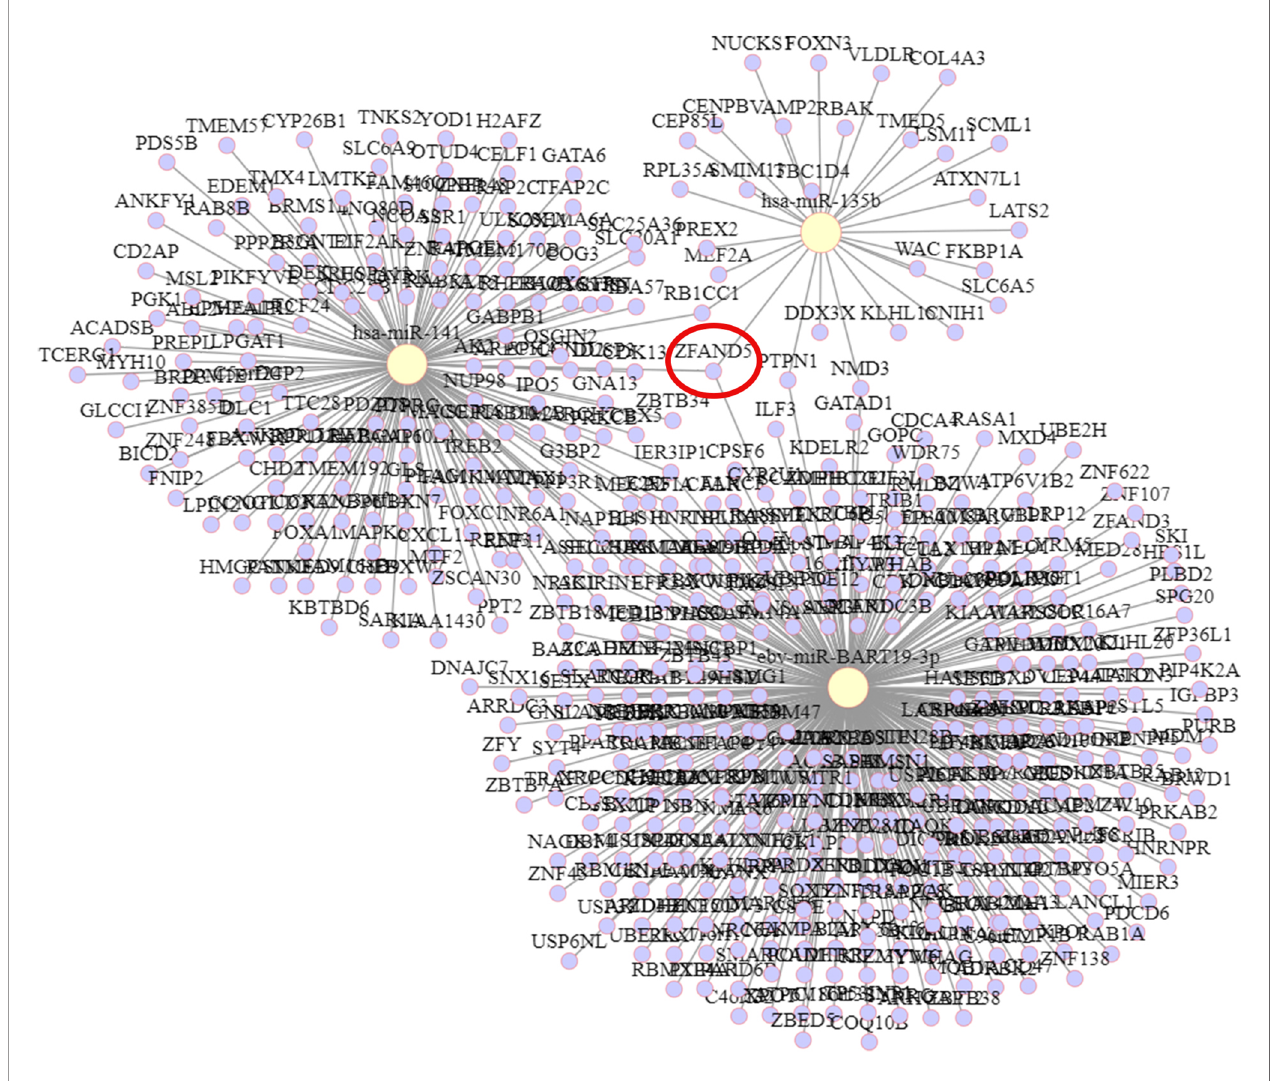
FIGURE 6 | Predicted target mRNA of